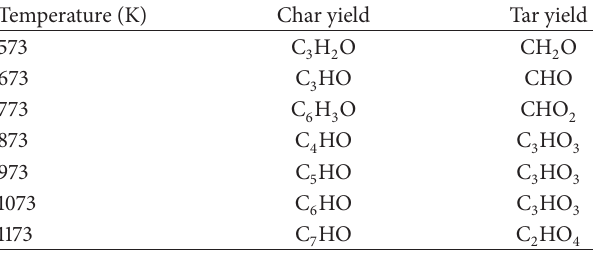
Table 4: Empirical formula of char and pyro-oil.